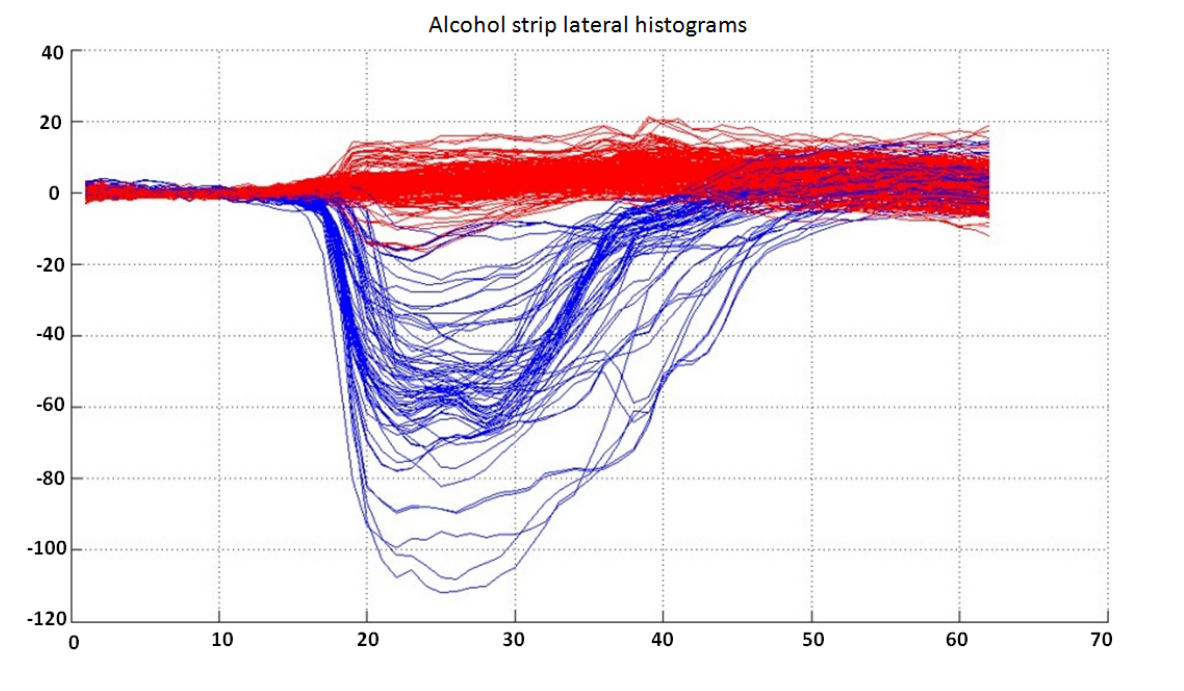
Figure 8. Lateral histograms used as the dataset for the classifier for the alcohol strip. Samples labeled as “negative” are represented in red, while “positive” samples are represented in blue. Note that the separability between classes is very good, and lateral histograms can be easily classified into three output categories (“positive”, “negative” or